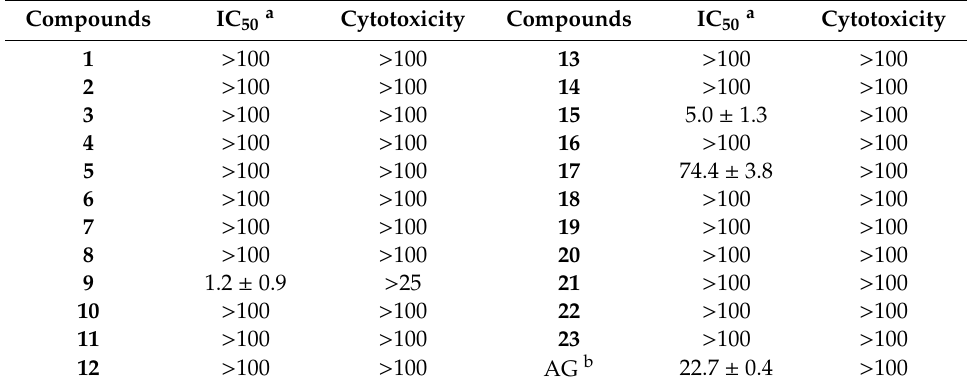
Table 3. NO inhibitory activities of Compounds 1 – 23 in RAW 264.7 cell line.